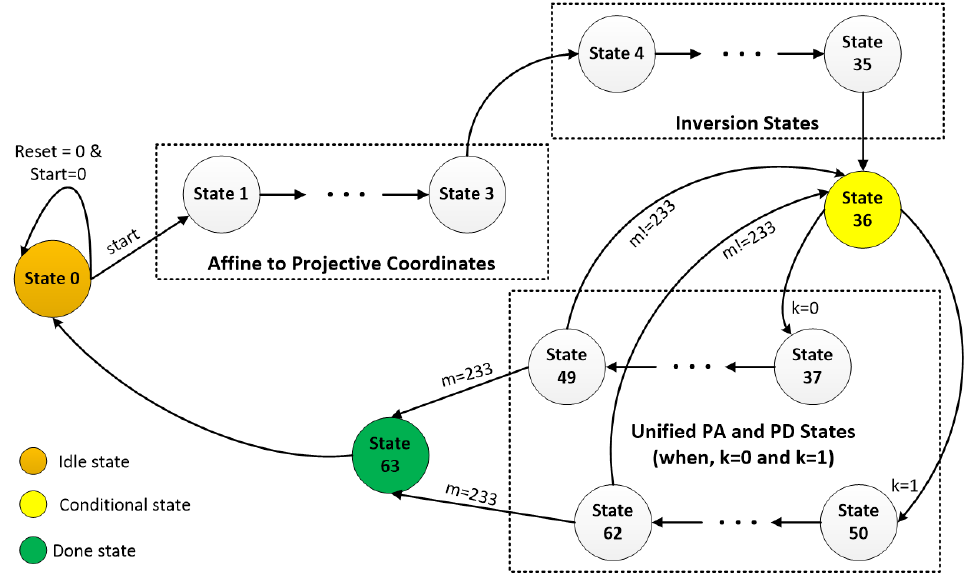
Figure 4. Control Unit for